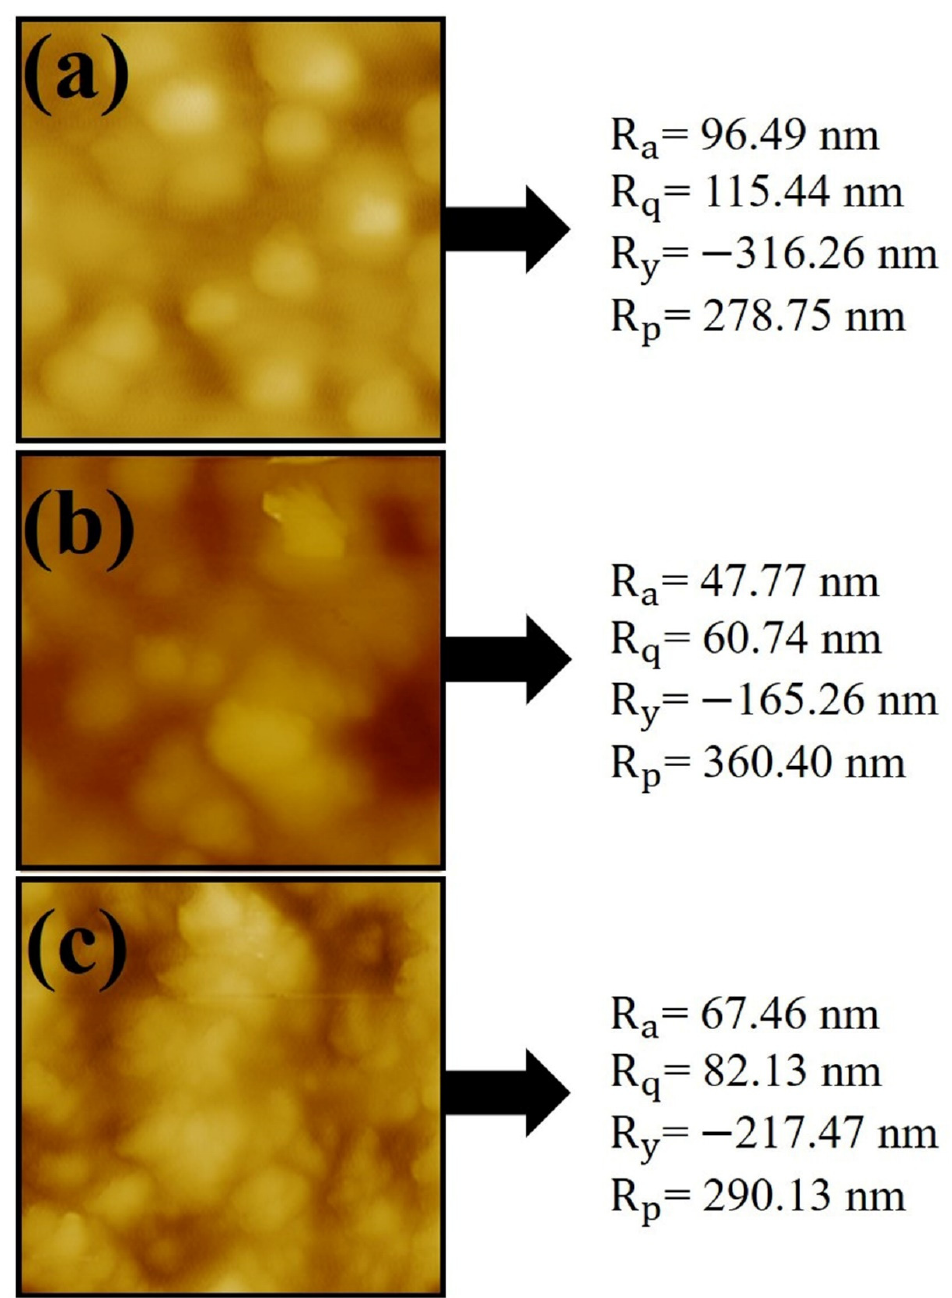
Figure 4. AFM images of complex carriers containing vitamin B 12 at ( a ) pH = 3, ( b ) pH = 6, and ( c ) pH = 9.